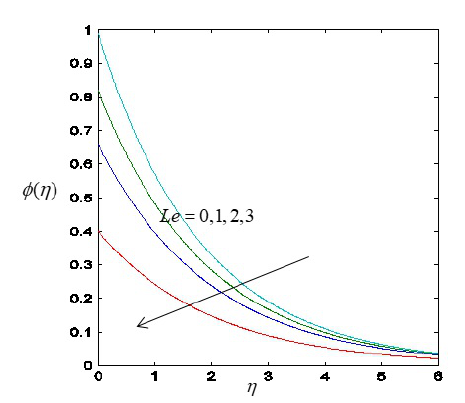
within the boundary layer region, leads to an enhance- ment in concentration profile. Fig. 13 represents the effect of ϕ ( η ) for various value of Nb . It has been noticed that an increases of N , the thermophoresis force is decreases b in the thermal boundary layer which results ground, con- centration of boundary layer thickness decreases. There- fore the nanoparticles concentration profile is decreases with increases of Nb. In Fig. 14 the effects of Lewis number with nanoparticles concentration profile has been plotted. It shows that the larger values of Lewis number Le causes a reduction in the nanoparticles concentration. Therefore the nanoparticles concentration profile is decreases with increases of Le